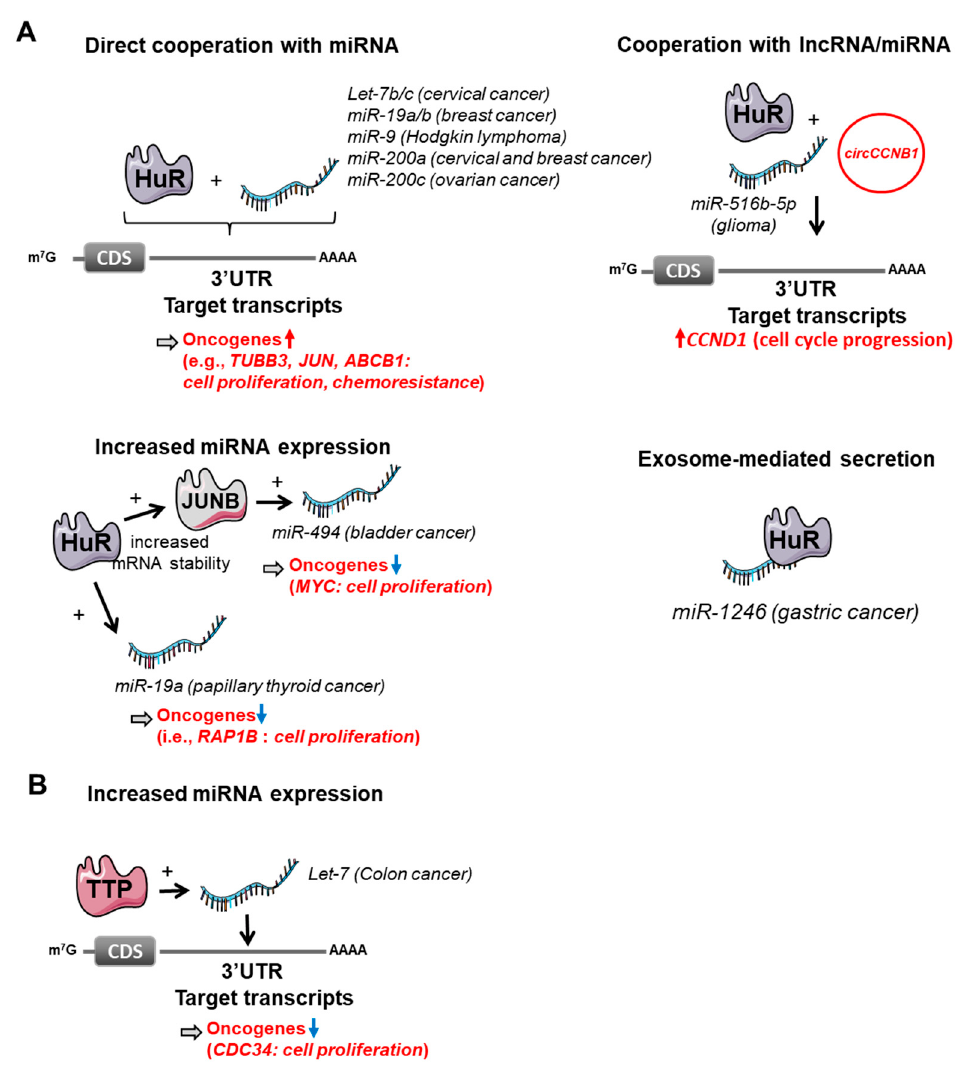
Figure 2. Cooperation between HuR, TTP and microRNA-dependent regulation. ( A ) HuR can co- operate with miRNAs by directly interacting with miRNAs and favoring their binding to their target mRNAs. This effect can also require the binding of circRNA (e.g., circ_CCNB1 ). HuR promotes exo- some-dependent miR-1246 secretion. HuR can stabilize JUNB mRNAs, thereby favoring its overex- pression, which in turn promotes miR-494 expression. ( B ) Finally, TTP can promote let-7 expression, which, in turn, decreases its mRNA targets (e.g., CDC34